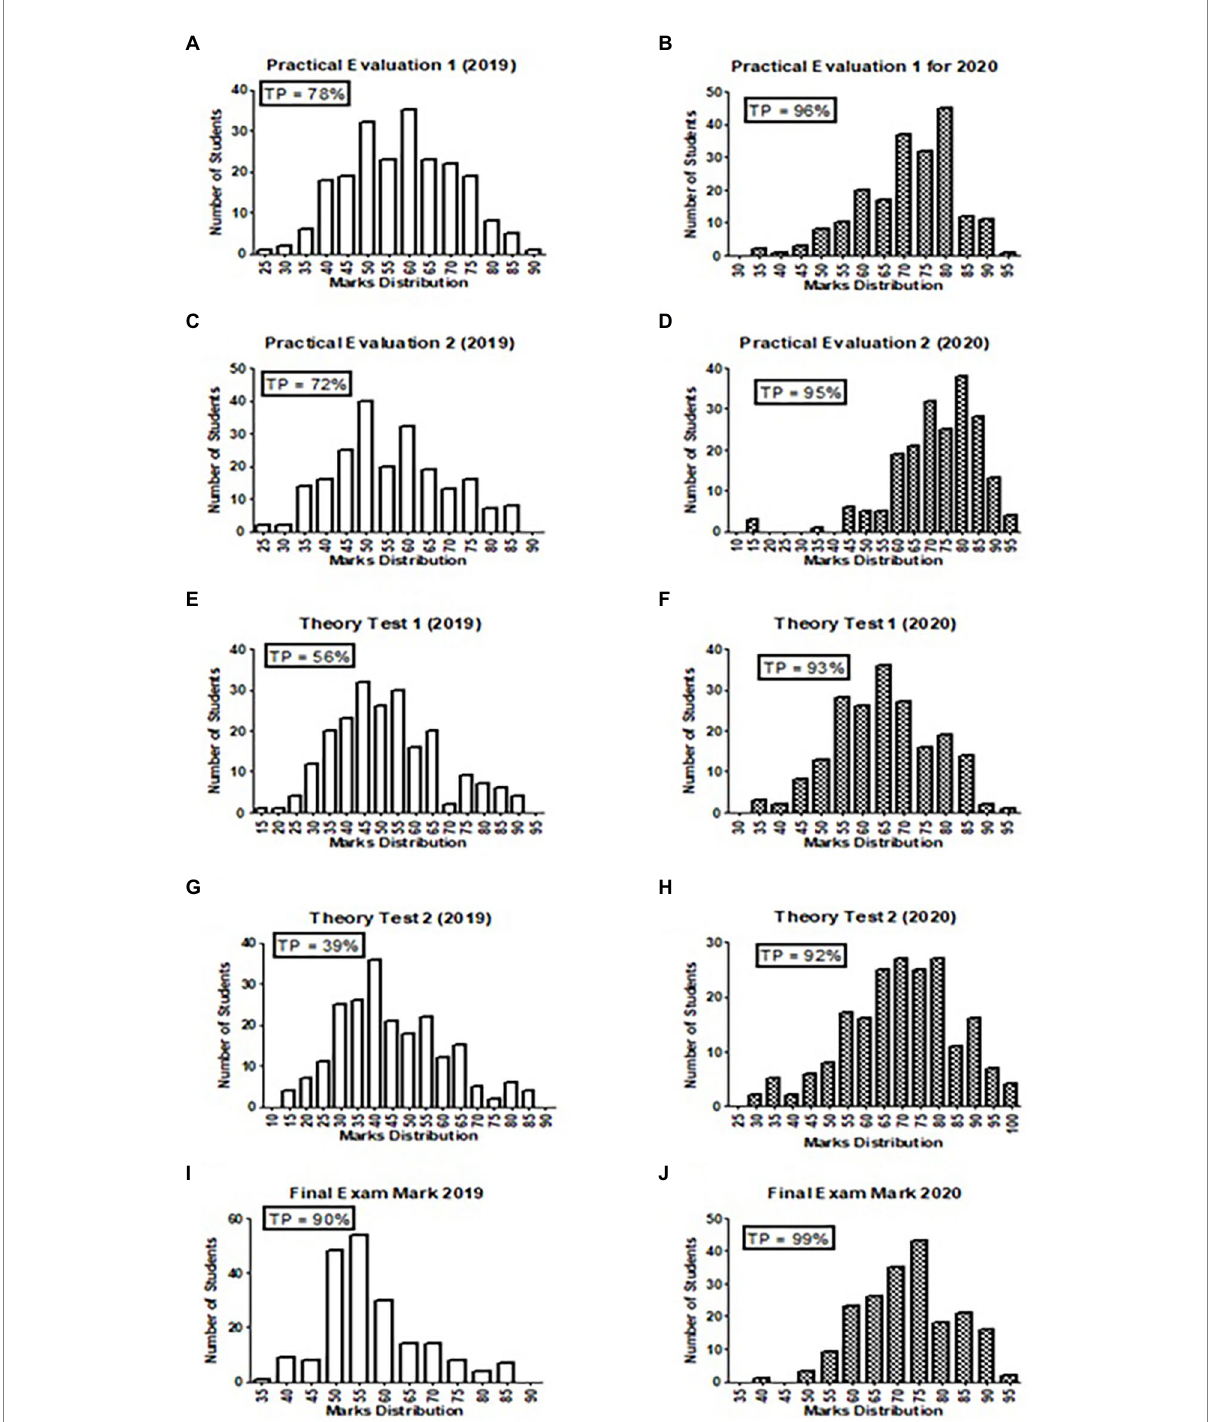
FIGURE 5 The following graphs depict the marks (%) distributions for all practical (A-D) , theory (E-H) , and exam assessments (I,J) . Each assessment event depicts the percentage of students in the MBS231 course that achieved more than 50%